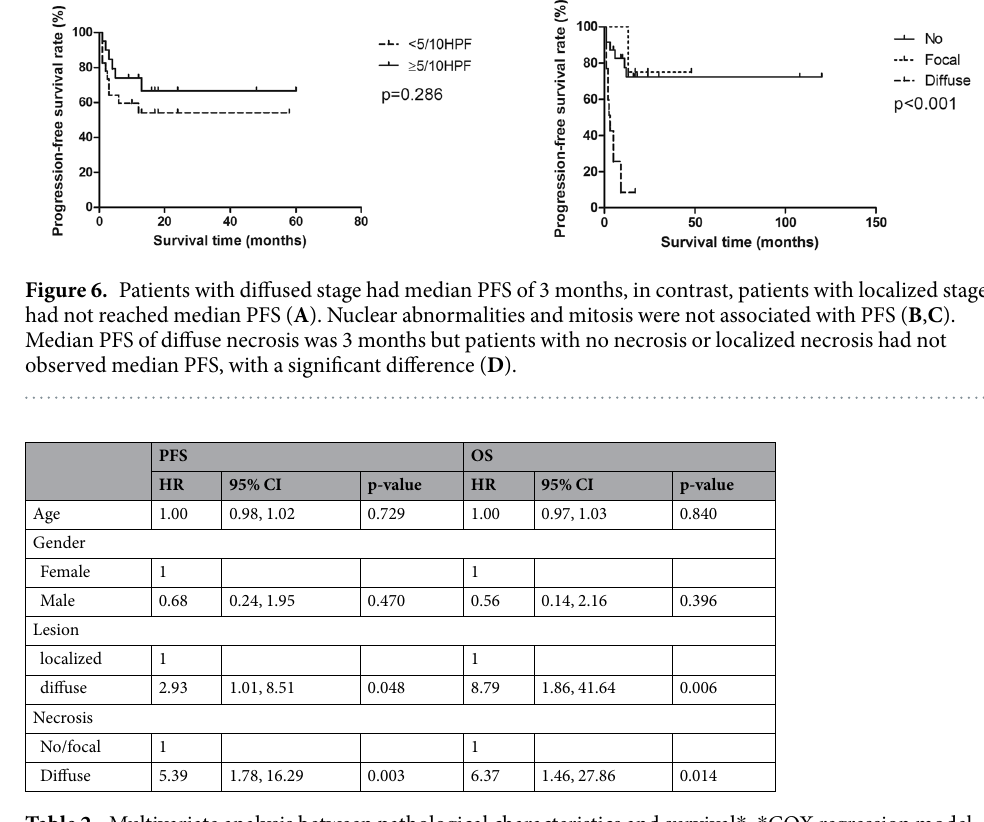
Table 2. Multivariate analysis between pathological characteristics and survival * . * COX regression model adjusting all factors